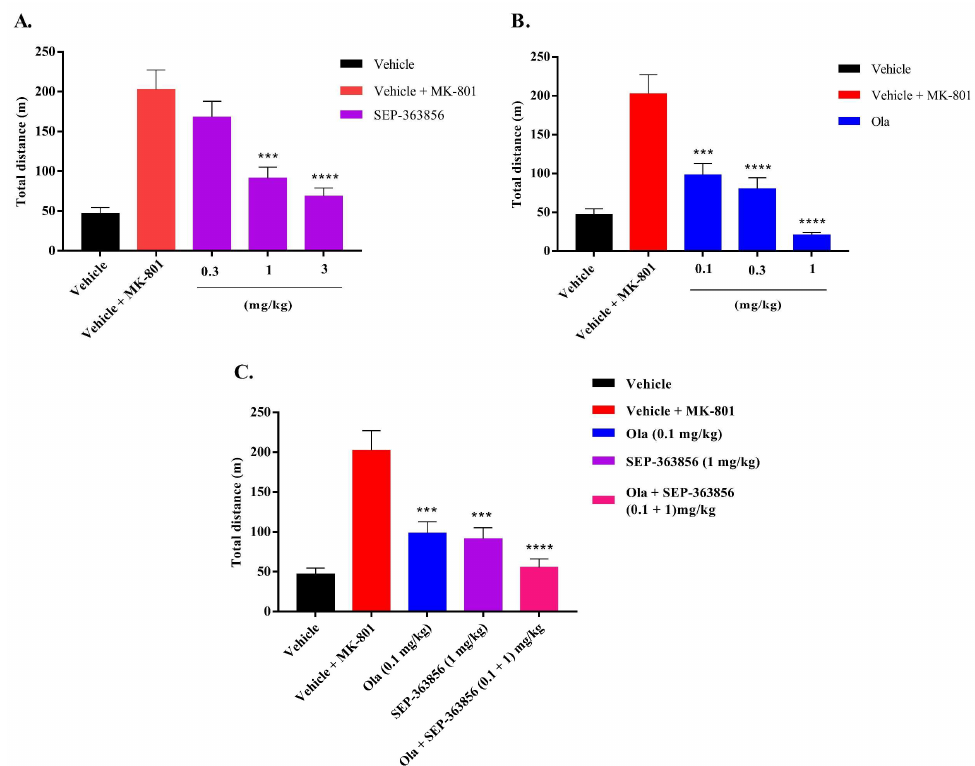
Figure 2. The effects of SEP-363856 and olanzapine on MK-801-induced hyperactive behavior in mice. Date expressed as mean ± S.E.M. ( n = 8). ( A ) Effect of SEP-363856 (0.3, 1, 3 mg/kg, p.o.) on MK-801-induced hyperactive behavior in mice. ( B ) Effect of Ola (0.1, 0.3, 1 mg/kg, p.o.) on MK-801-induced hyperactive behavior in mice. ( C ) Effect of Ola (0.1 mg/kg) and SEP-363856 (1 mg/kg) co-administration on MK-801-induced hyperactive behavior in mice (compared with model group, *** p < 0.001, **** p < 0.0001).